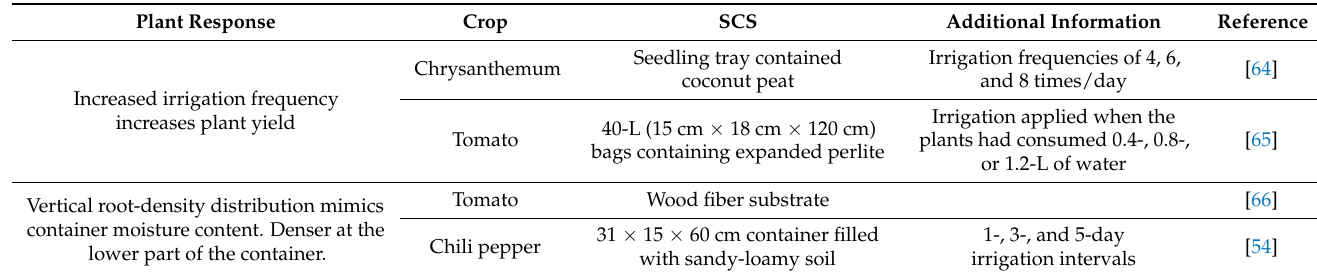
Table 3. Plant responses to irrigation